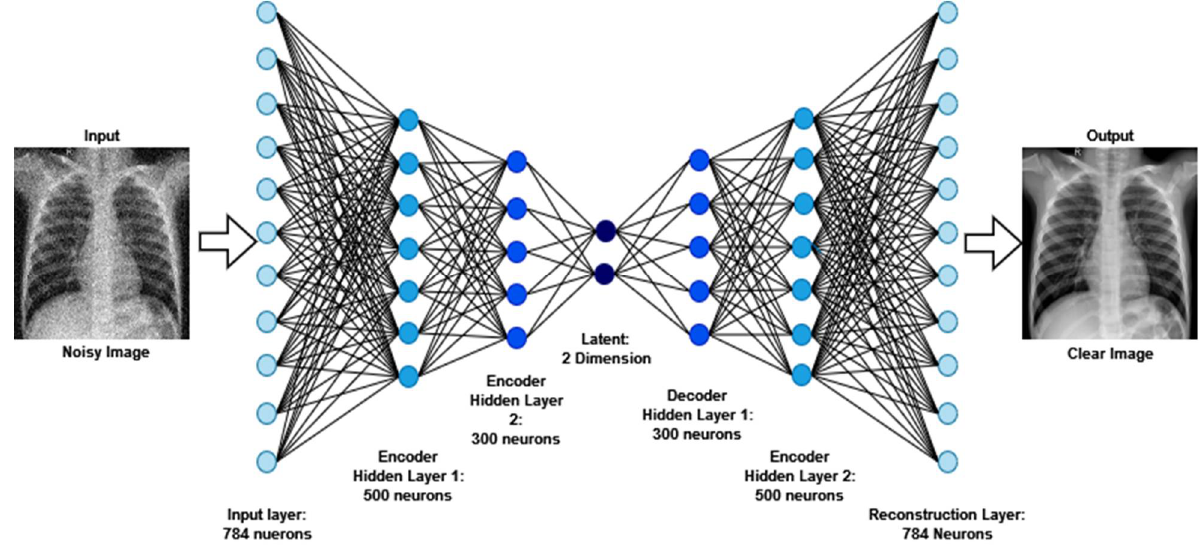
Figure 3. The output and architecture of the image denoising from raw noisy